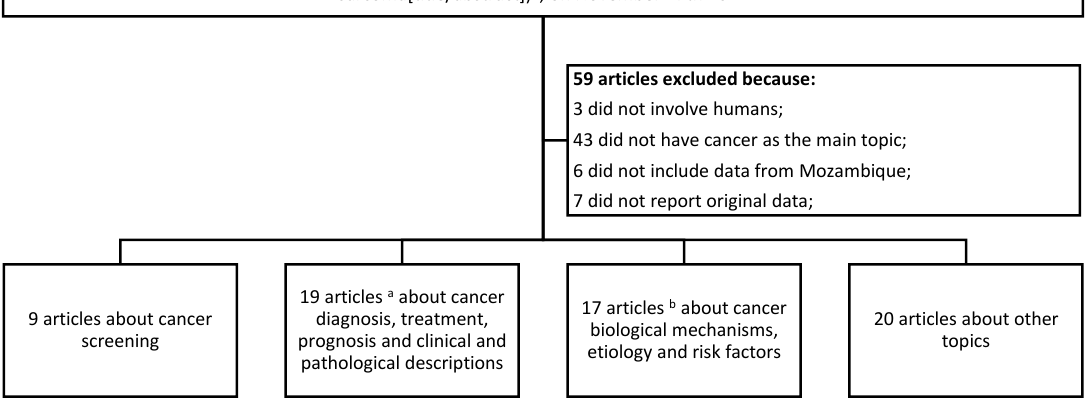
Figure 1. Flow chart describing the process of selection of articles with Mozambique cancer data from those published in PubMed ® between 1990 and 2022. a Includes articles about Kaposi sarcoma (N = 5); breast (N = 4), cervical (N = 2), esophageal (N = 2), liver (N = 1), bladder (N = 1), colorectal (N = 1), and oropharyngeal (N = 1) cancers; lymphoma (N = 1); and several cancers (N = 1). b Includes articles about cervical cancer (N = 5); Kaposi sarcoma (N = 3); liver (N = 1), breast (N = 1), esophageal (N = 1), stomach (N = 1), lung (N = 1), penile (N = 1), vulvar (N = 1), and eye (N = 1) cancers; and several cancers (N = 1). *: synonyms.